Question: What type of chart is this?
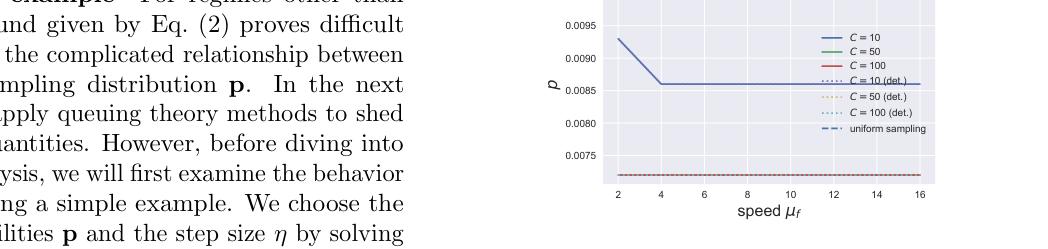
Answer: line